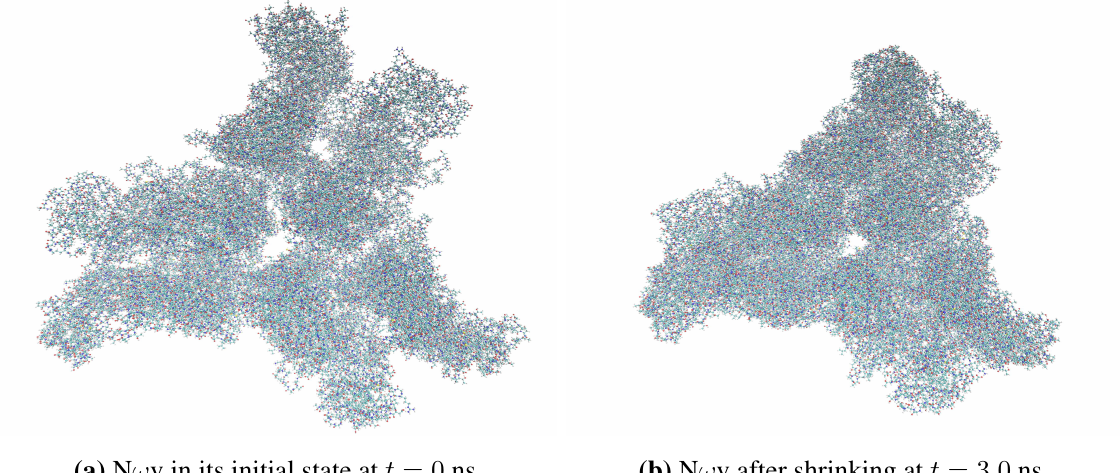
Figure 4. Snapshots of the Nudaurelia capensis omega virus (N ω V) triangular structure before ( a ) and after ( b ) contraction due to strong protein-protein